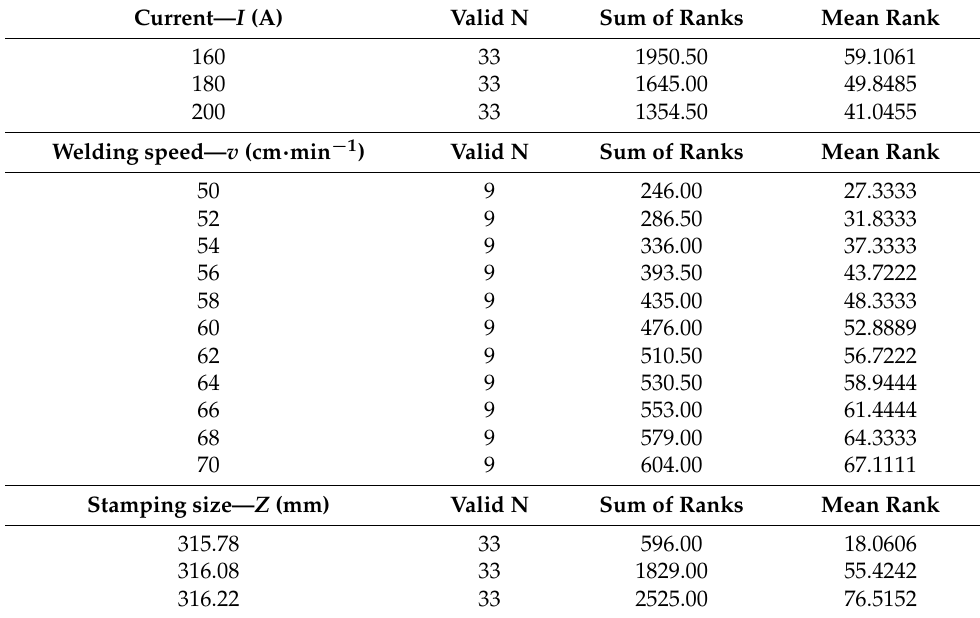
Table 7. Results of Kruskal–Wallis analysis of variance of individual parameters of the